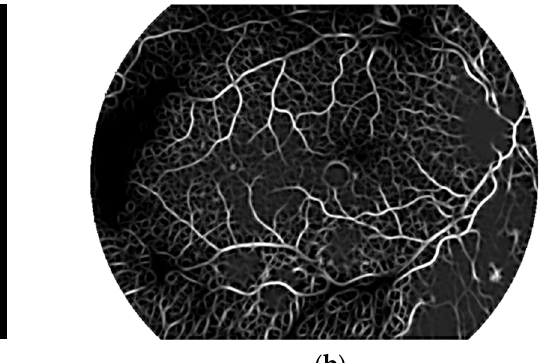
( c ) Figure 10. ( a ) Original image, ( b ) image after conversion to grayscale with green channel and ( c ) image after noise removal. The third and the fourth steps are connected with image enhancement before vessel segmentation. It is done on the basis of histogram equalization (which allows enhancement of the image contrast) and brightness correction. Images obtained after both of these stages are presented in Figure 11.